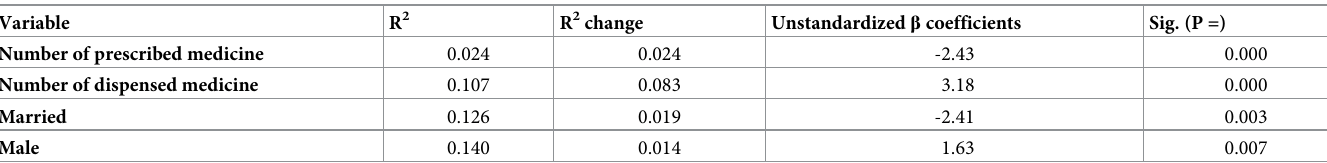
Table 6. Regression estimates (stepwise linear regression) for background characteristics, and pharmaceuticals factors in overall satisfaction, December